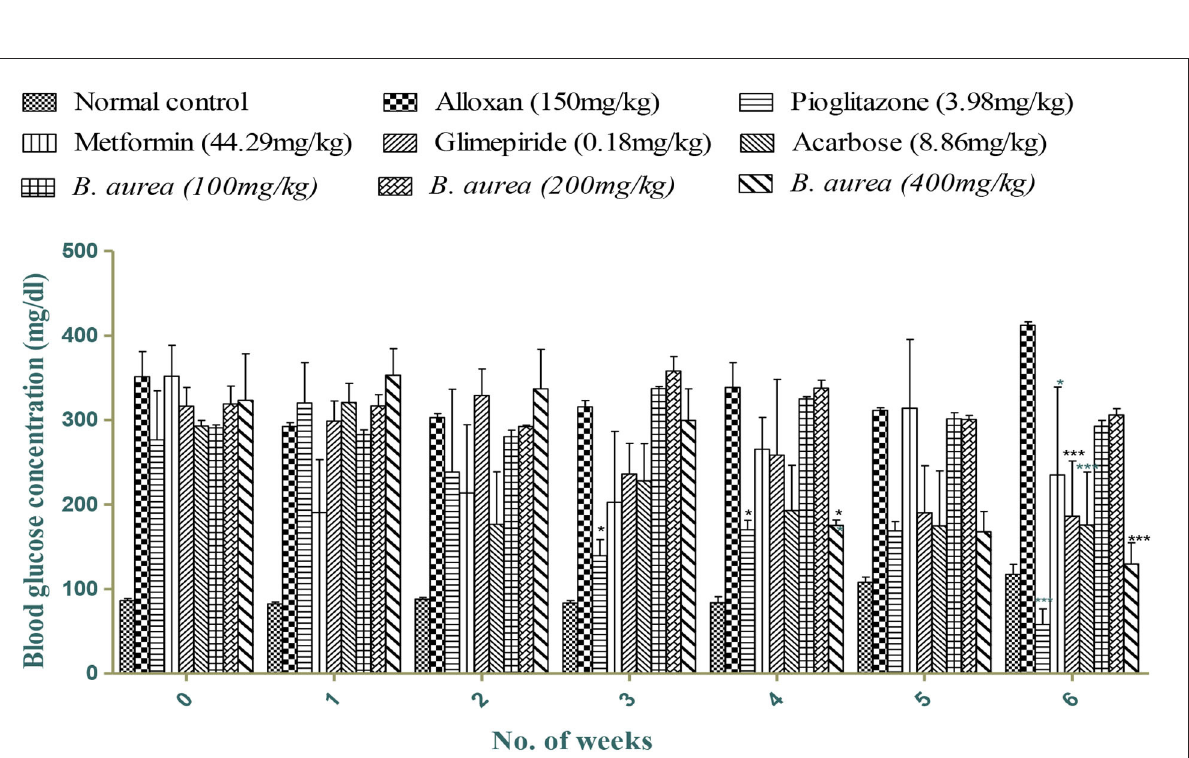
FIGURE2 Effect of treatments on blood glucose concentrations (mg/dL). *** p < 0.001, ** p < 0.01, * p < 0.05 significant values were obtained after comparison with the diseased